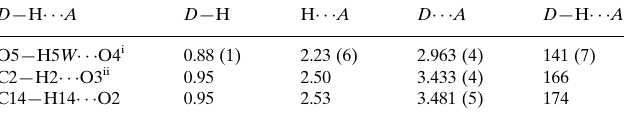
Hydrogen-bond geometry (A˚ , (cid:4)